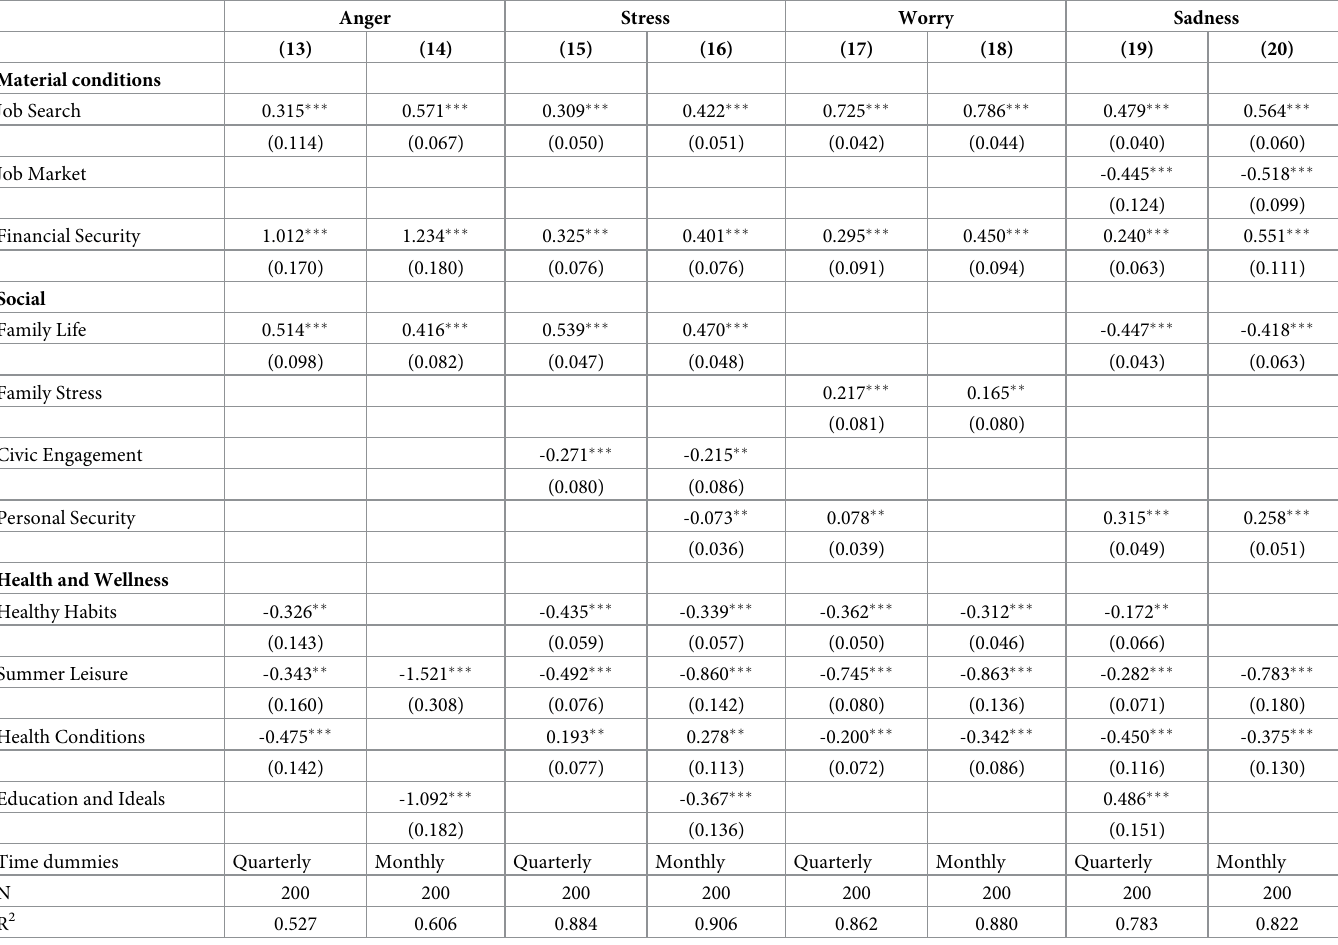
Table 2. Regression of categories on subjective well-being data–negative affects (national